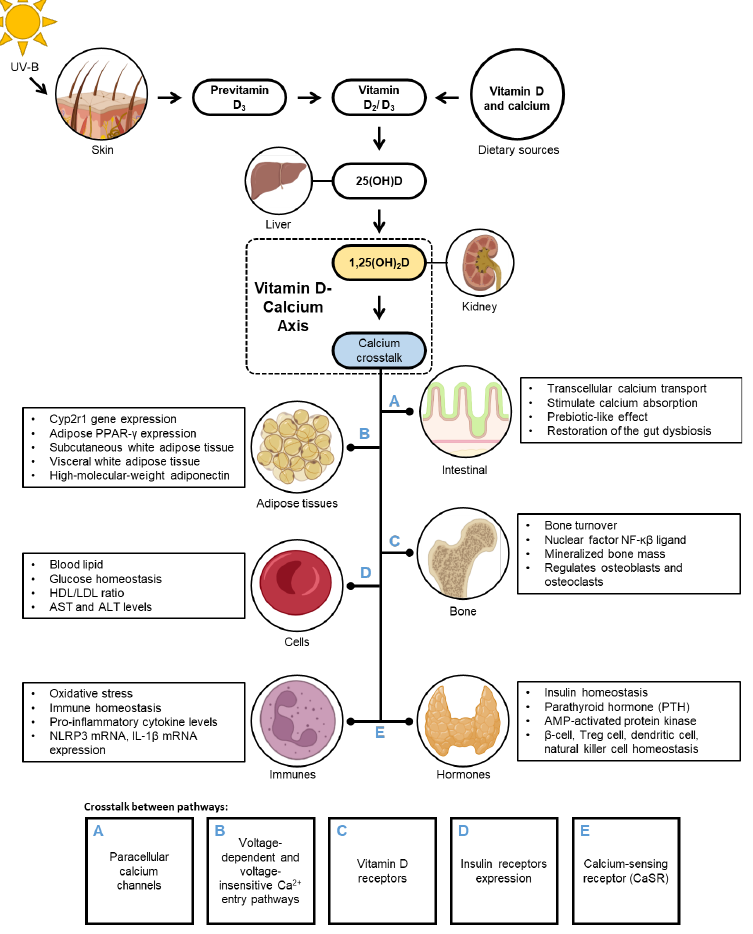
Figure 2. The regulation of vitamin D-calcium axis in obesity.